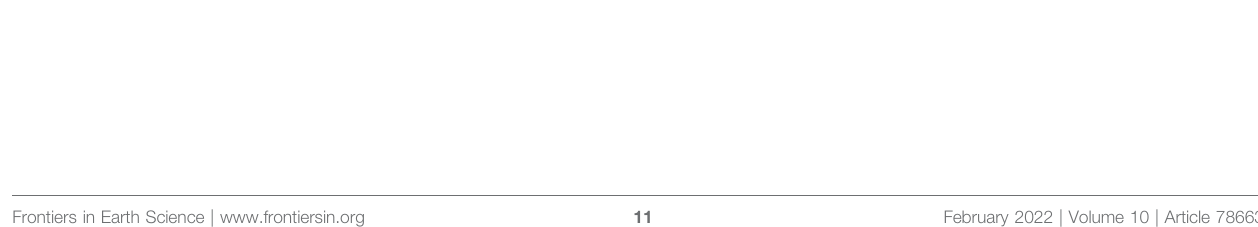
Frontiers in Earth Science |